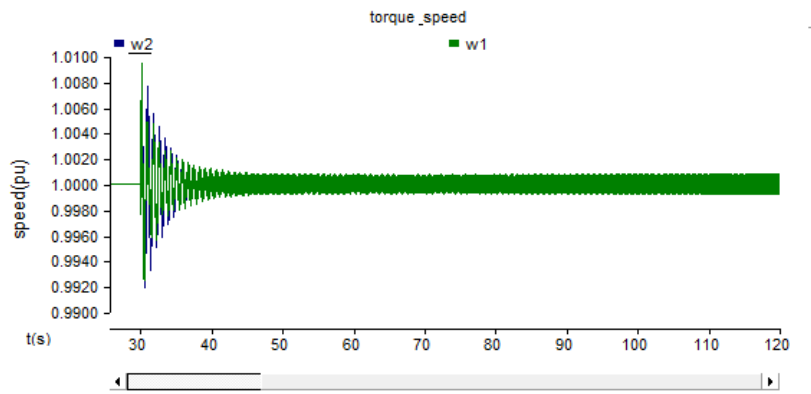
Figure 13. Generator speeds while speed of only one type of generator is taken as the input signal of the 20.5 Hz mode of